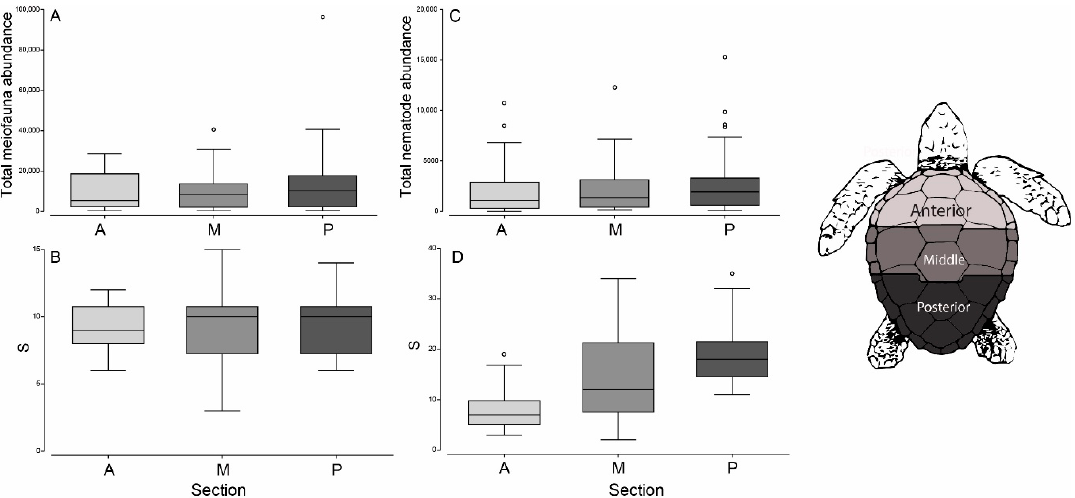
Figure 1. Meiofauna and nematode abundance and taxon richness for each carapace section, represented by Box-whisker plots (median, quartiles and ranges) S = taxon richness. ( A ) Total meiofauna abundance, ( B ) meiofauna taxa richness, ( C ) nematode abundance, ( D ) nematode genera richness.